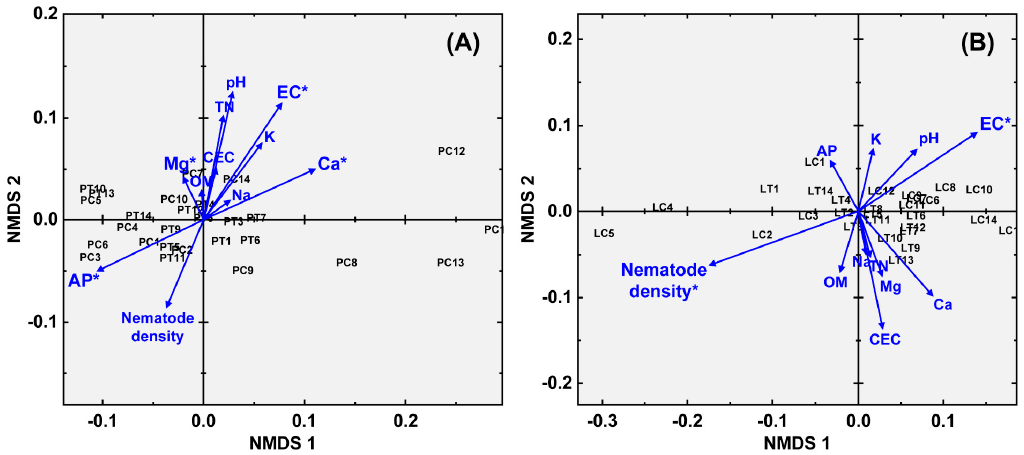
Figure 3. Nonmetric multidimensional scaling ordination between the morphological parameters of the ( A ) P. densiflora and ( B ) L. kaempferi and soil properties. Arrow direction indicates the correlation slope, and arrow length indicates the degree of influence of the various factors; * p < 0.05.